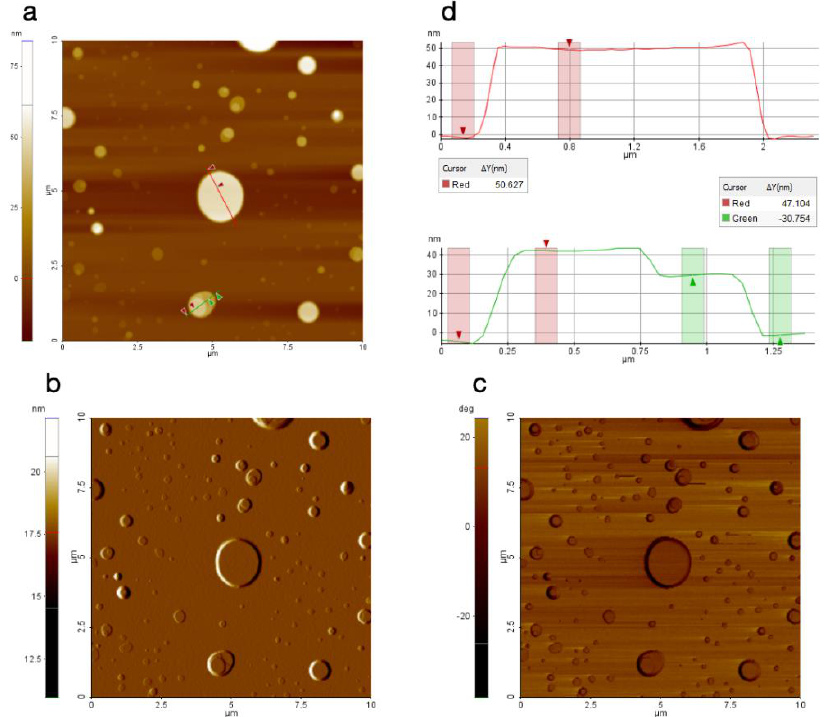
Figure 3. AFM image of AKV006 (DOPC) scanned at a location with “thicker” deposited lipid film, where ( a ) shows the topography data and ( b ) the amplitude signal ( c ) the phase signal, and ( d ) the topography profile for the two lines drawn in the topography image.